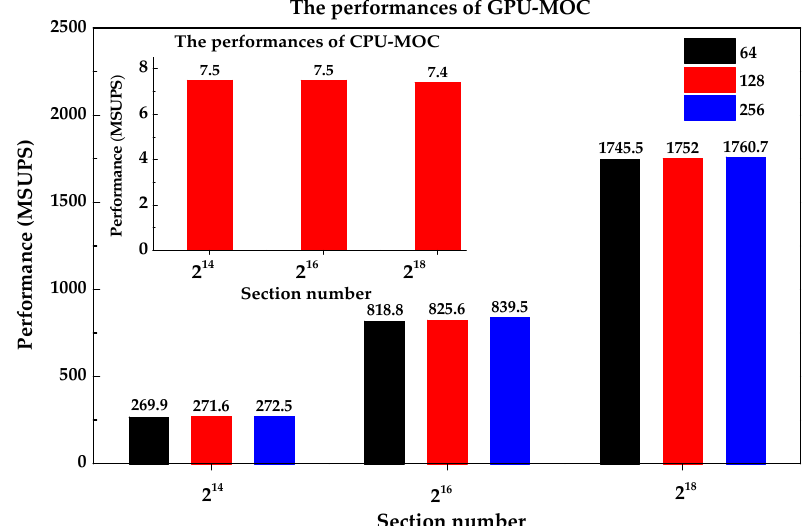
Figure 3. Performances of CPU-MOC in different section numbers and GPU-MOC in different section numbers with different block sizes. Table 1. Speedup ratios of GPU-MOC to CPU-MOC.